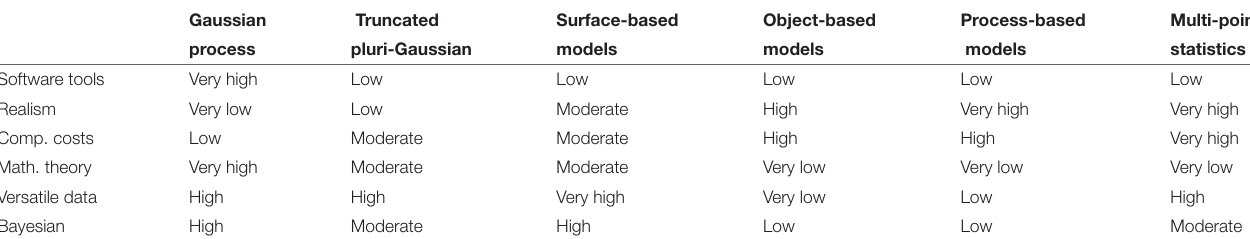
TABLE 2 | Overview of the different paradigms for sub-surface structure generation applied in hydrogeology. Gaussian Truncated Surface-based Object-based Process-based Multi-point process pluri-Gaussian models models models statistics Software tools Very high Low Low Low Low Low Realism Very low Low Moderate High Very high Very high Comp. costs Low Moderate Moderate High High Very high Math. theory Very high Moderate Moderate Very low Very low Very low Versatile data High High Very high Very low Low High Bayesian High Moderate High Low Low